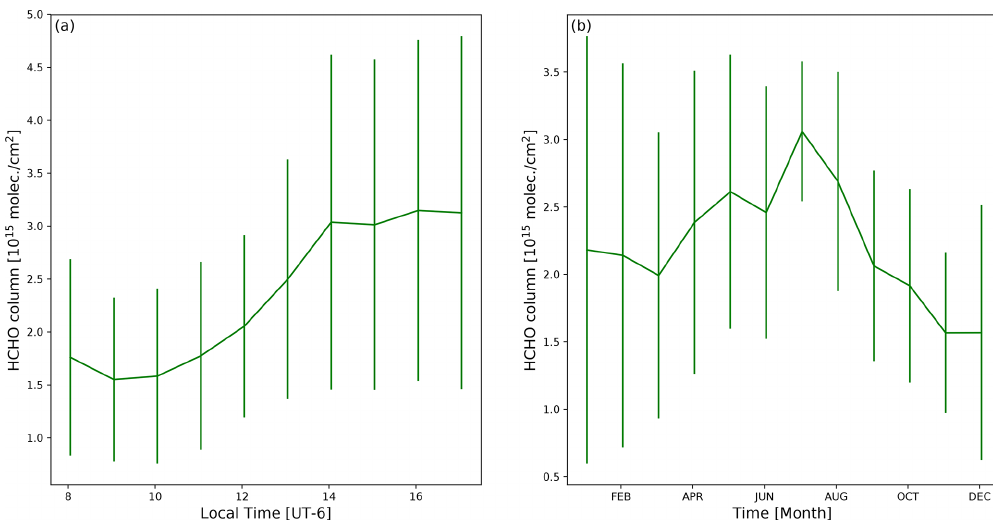
Figure 11. Hourly (a) and seasonal (b) HCHO VCD cycles at Altzomoni from FTIR